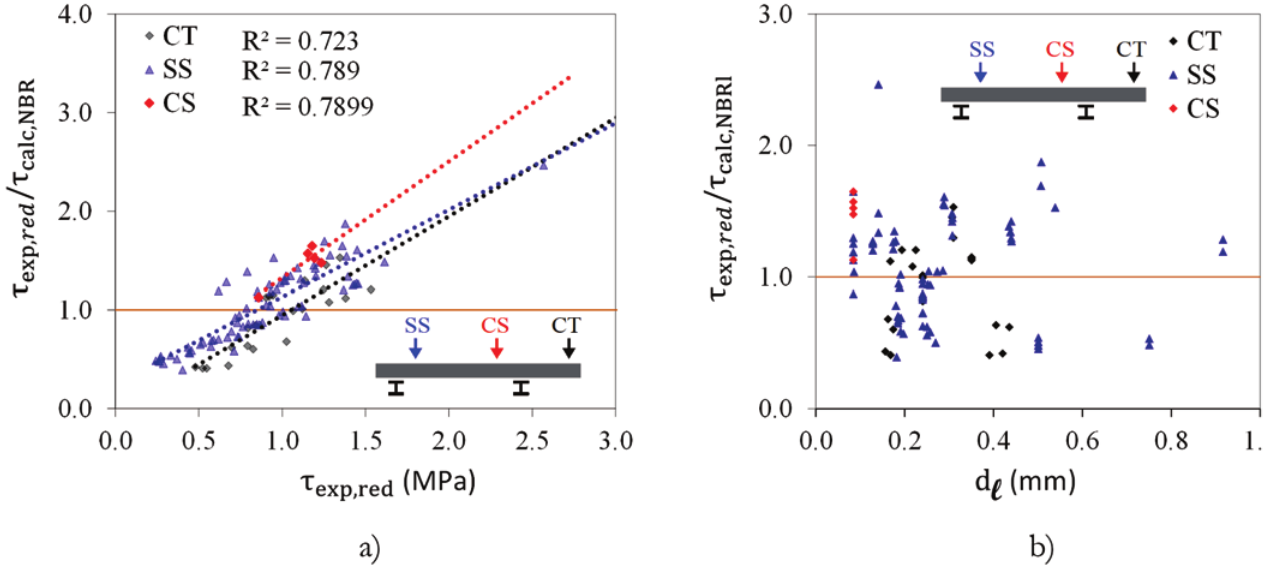
Level of accuracy of the punching model from ABNT NBR 6118:2014 ( γ